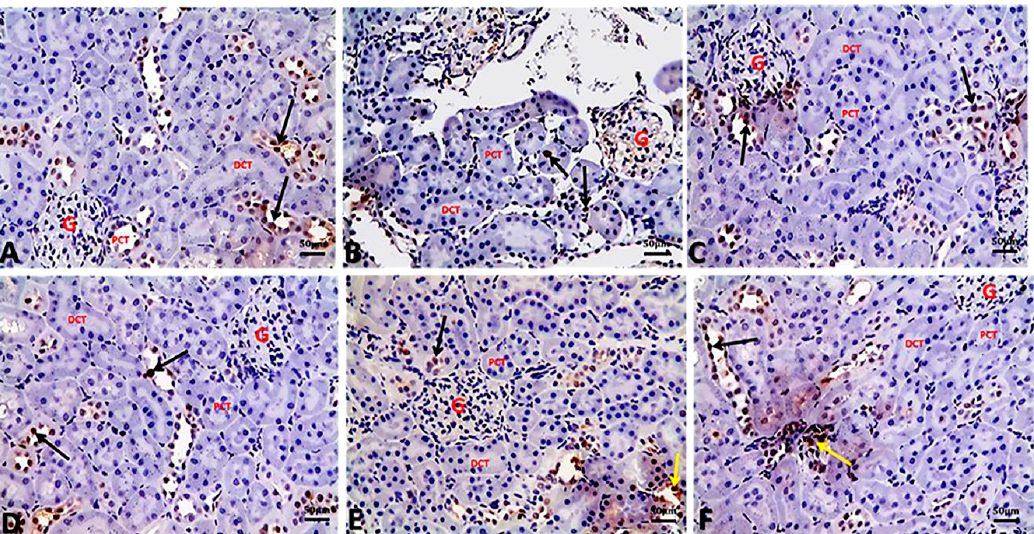
Figure 7. Representative photomicrographs of immuno-histochemical localization of PCNA in kidney sections of different groups (PCNA IHC, bar = 50 µm, black arrow: nuclear immune-expression of renal epithelium, yellow arrow: nuclear immune-staining within interstitial inflammatory cells). ( A ) Control group showing nuclear immune-staining of PCNA within the epithelial lining of the renal tubules. ( B ) BM group showing marked decrease in PCNA immuno-staining within the renal tubular epithelium. ( C ) AO/0.5 and ( D ) AO/1 showing nuclear immune-staining of PCNA within the renal tubules as control group. ( E ) BM + AO/0.5 showing nuclear immune-staining of PCNA within the renal tubules and interstitial inflammatory cells in-between renal tubules. ( F) BM + AO/1 showing nuclear immune-staining of PCNA within the renal tubules and interstitial inflammatory cells.